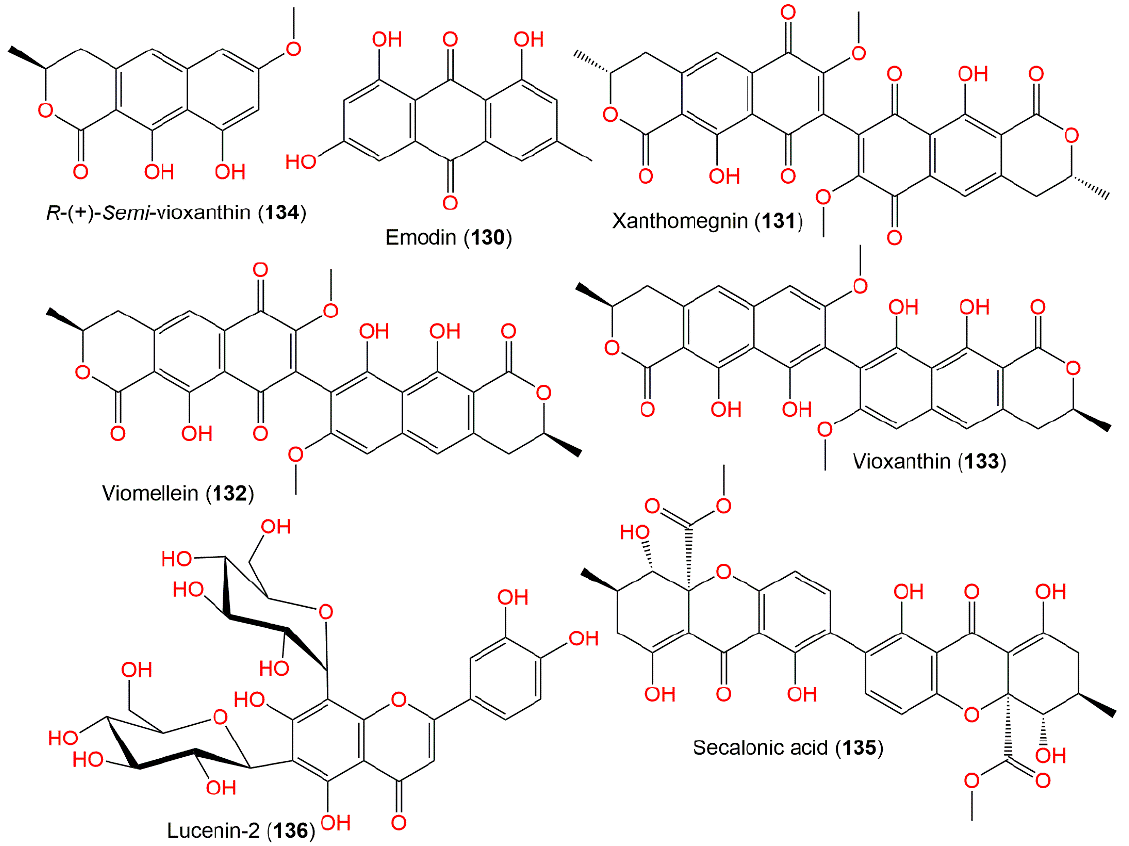
Figure 12. Quinone ( 130 – 132 ) and xanthine ( 133 – 136 ) derivatives and flavonoids ( 135 ) reported from A. ochraceus.